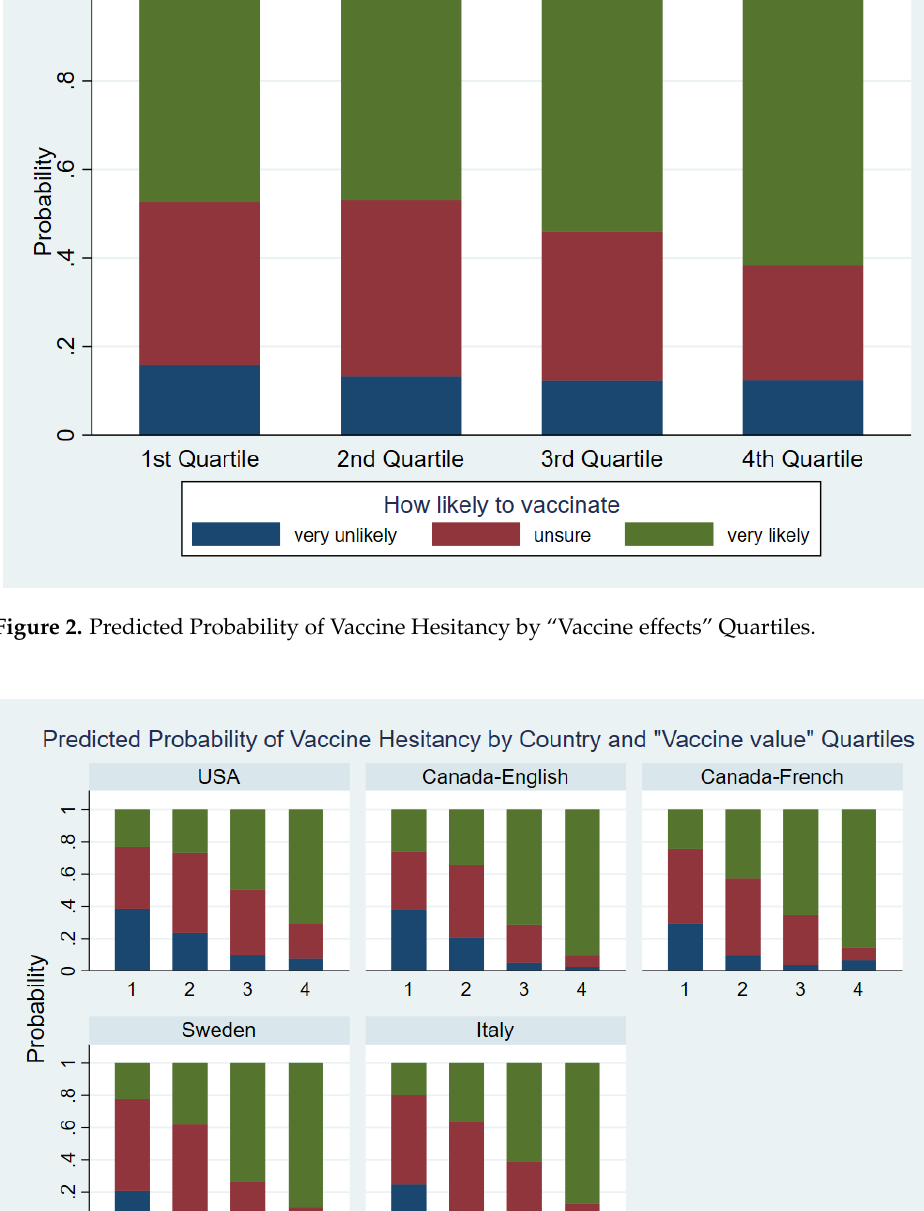
Figure 2. Predicted Probability of Vaccine Hesitancy by “Vaccine effects” Quartiles .